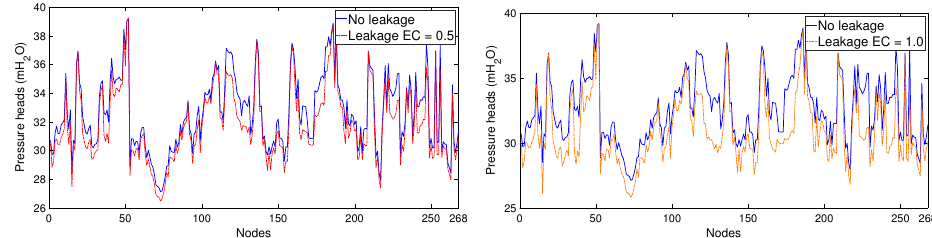
Figure 3. Comparing nominal and leak pressure head behaviour.